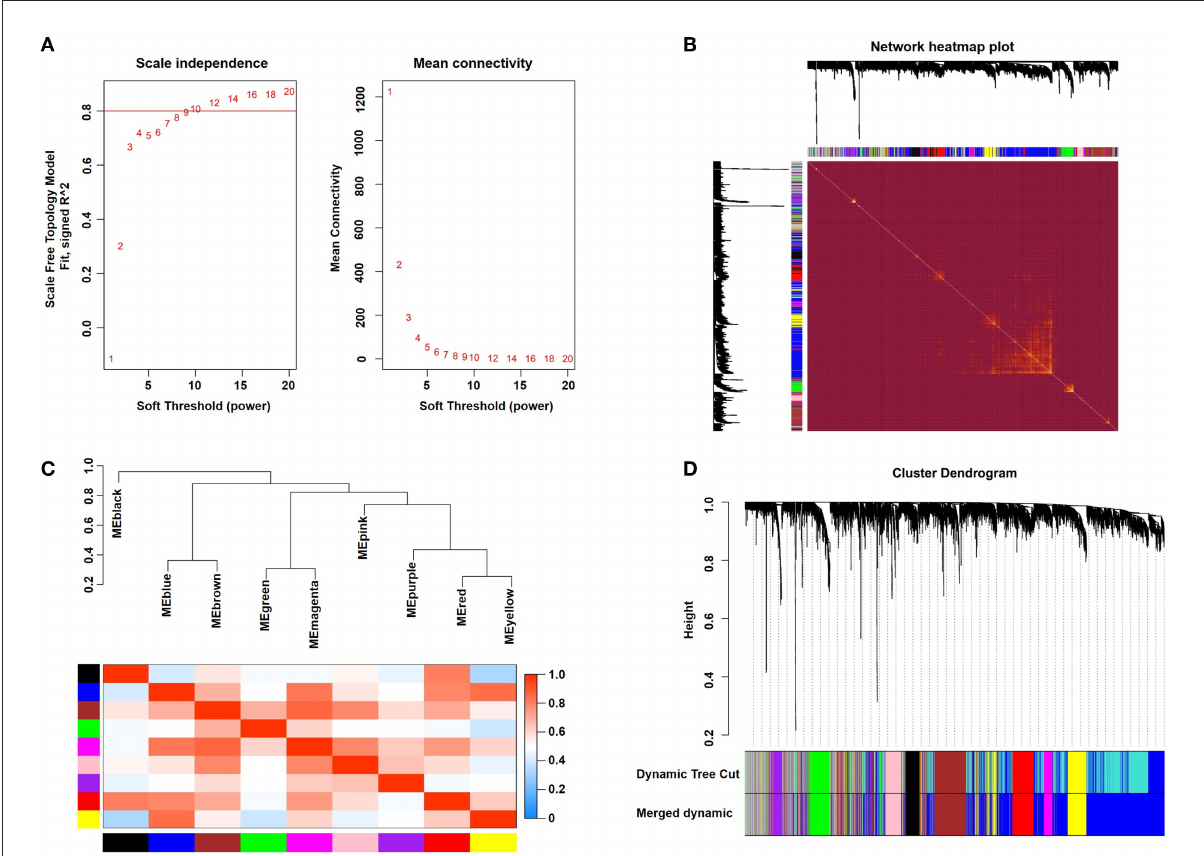
FIGURE1 Weighted gene coexpression network analysis. (A) Analysis of network topology for various soft-thresholding powers. (B) Representative heatmap representing the topological overlap of the gene network. (C) Correlations among the indicated modules are shown. (D) The gene clustering dendrograms are